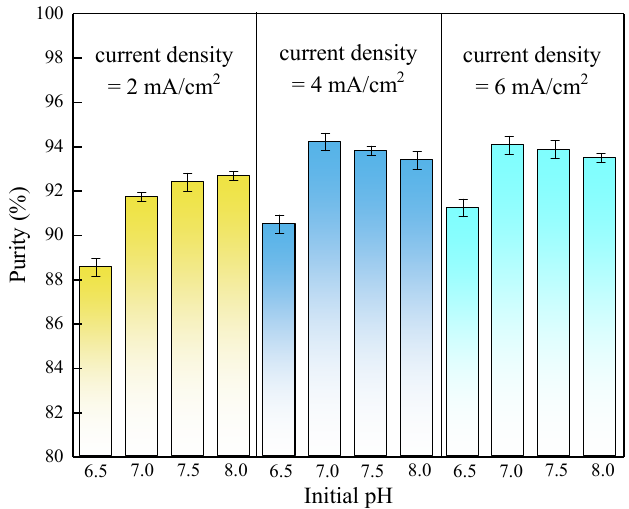
Figure 5. XRD diffractogram of precipitates.